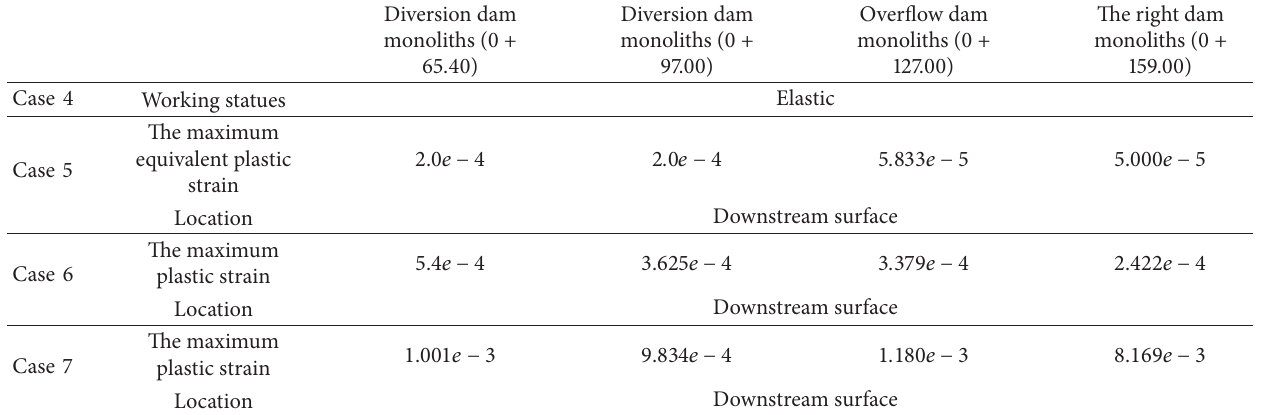
Table 6: The maximum equivalent plastic strain of the typical dam monoliths. (Analysis Cases